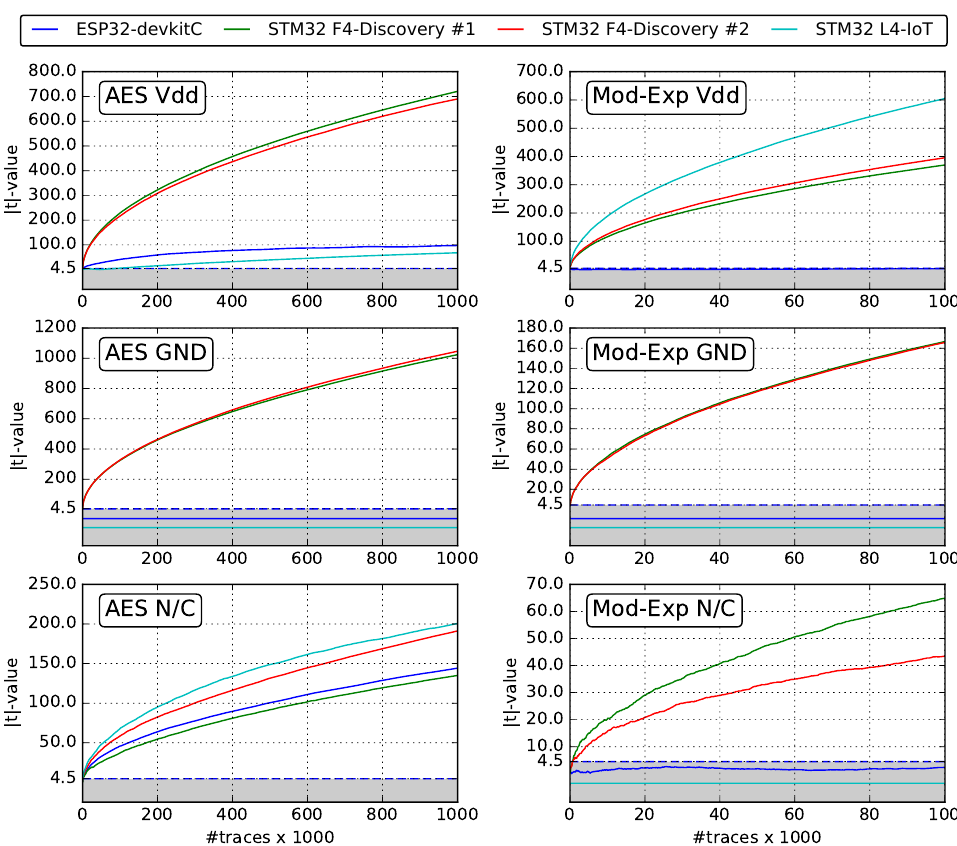
Figure 10: Leakage Assessment on mbedTLS AES and modular exponentiation (Mod-Exp) with {Vdd, GND, N/C} connected to the ADC on all platforms. Flat lines on the bottom are constant zero, shifted for